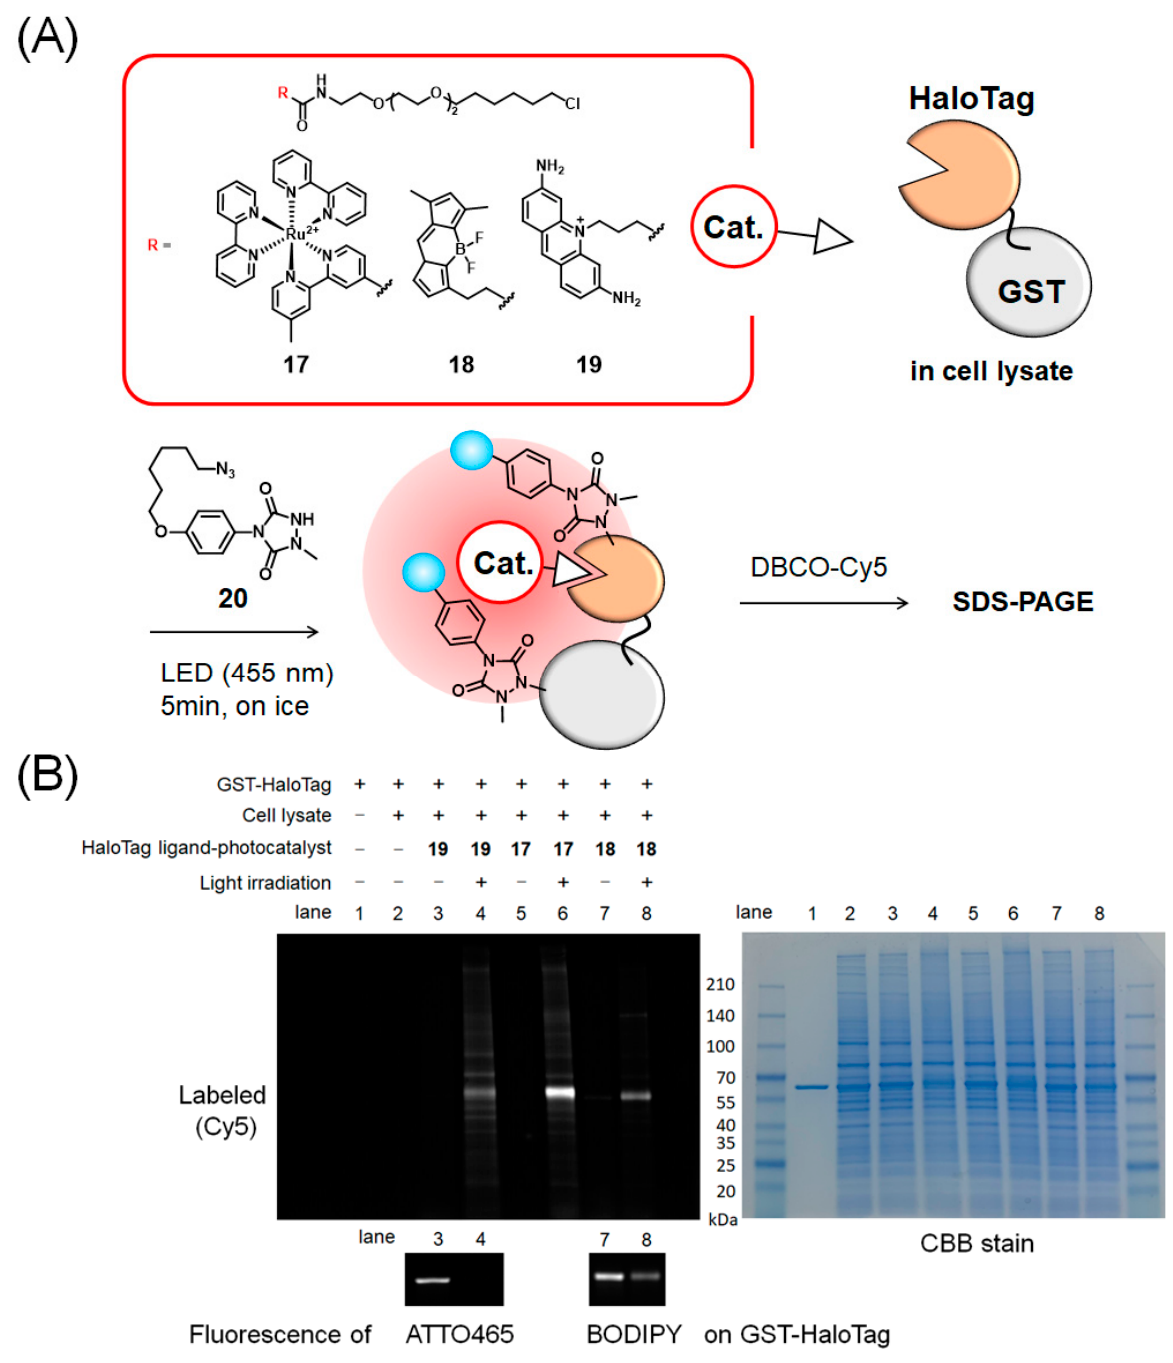
Figure 5. Photocatalytic proximity labeling using HaloTag ligand-conjugated photocatalysts and gluatione S-transferase (GST)-HaloTag. ( A ) Scheme of the labeling. ( B ) Detection of labeling and fluorescence of photocatalyst on GST-HaloTag.